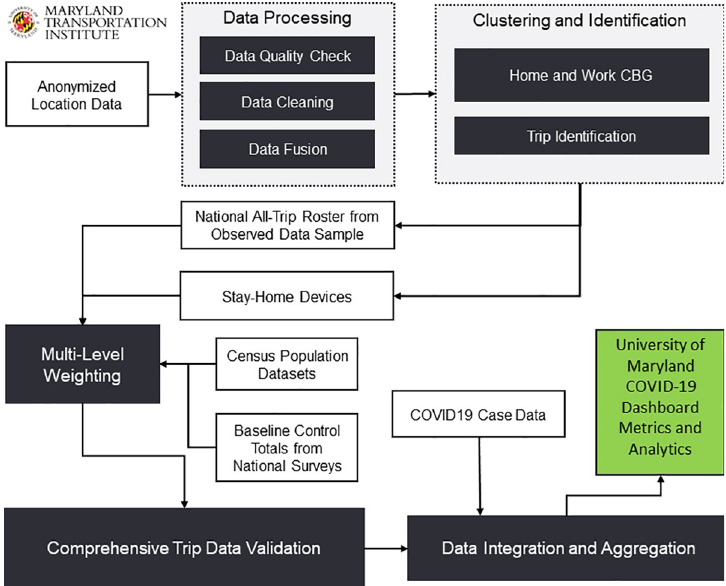
Fig 1. Data processing and methodology framework. Reprinted from [34, 36] under a CC BY license, with permission from Zhang L et al., original copyright 2020.